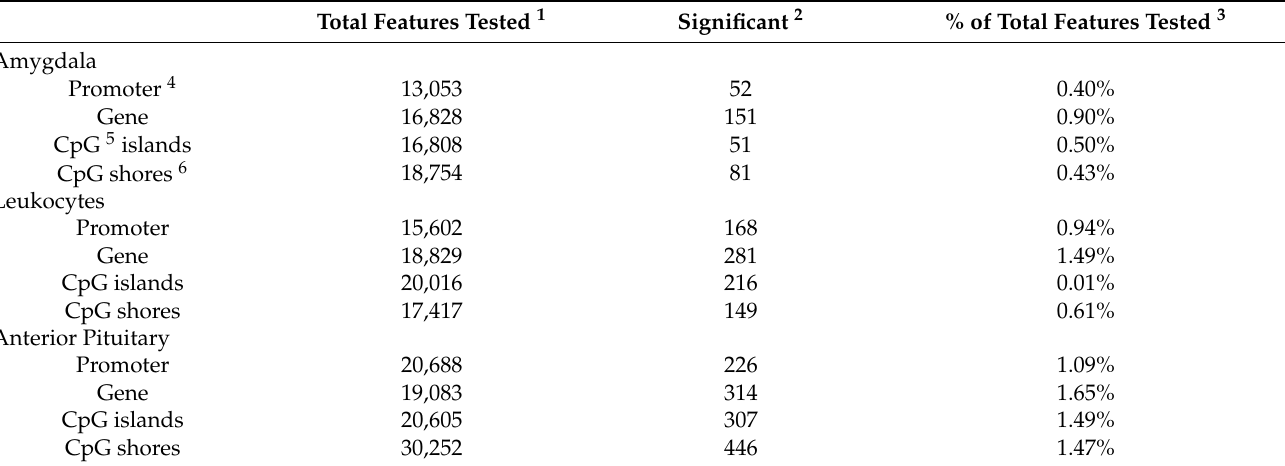
Table 2. The number of genomic features with high variability in DNA methylation between cows in the Control group.